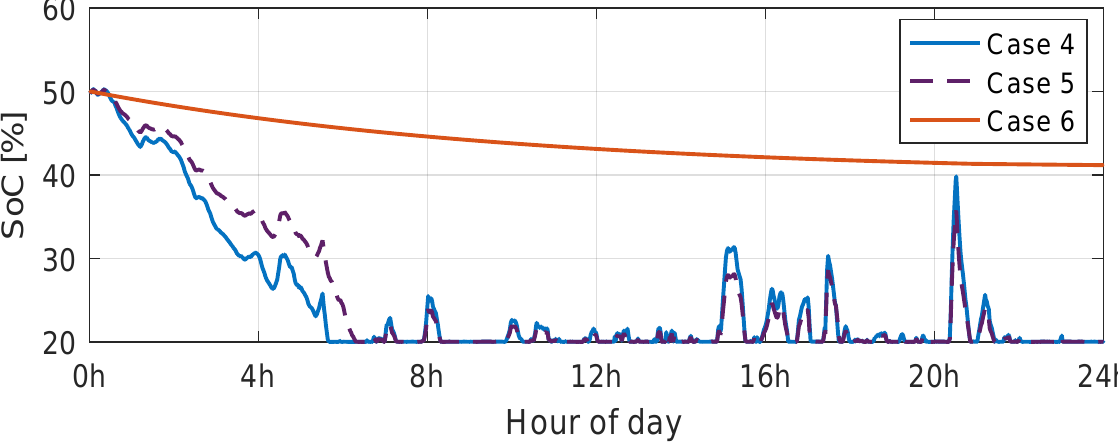
Figure 29. Strategy 2: SoC signals with Case 4: λ 1 = 100, λ 2 = 0, Case 5: λ 1 = λ 2 = 50, and Case 6: λ 1 = 0, λ 2 = 100. Initial SoC of 50% and P SCHED with maximum ± 30% error.